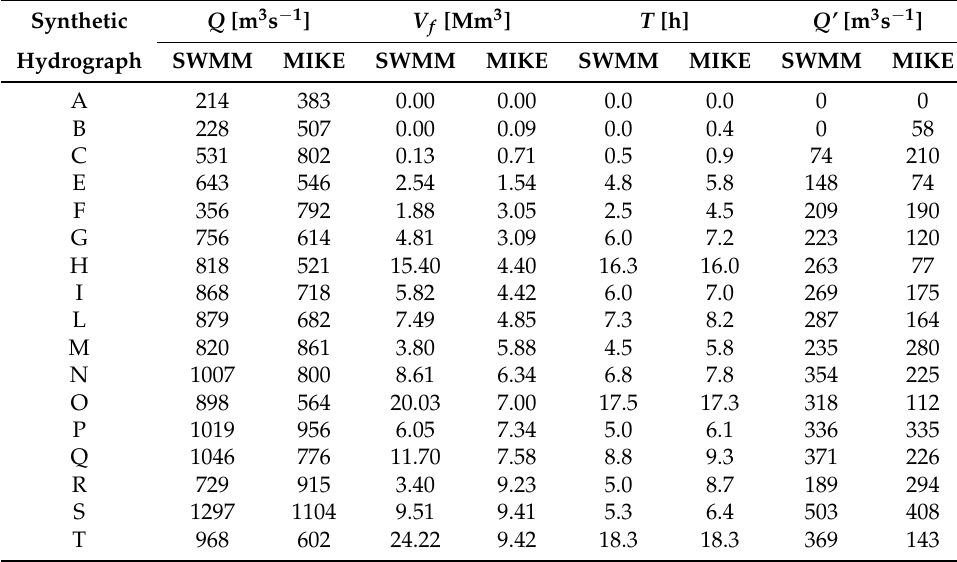
Table 5. Comparison among hydrographs simulated by SWMM and MIKE FLOOD models in Corace watershed (Calabria, Italy) (n = 17 rainfall-runoff